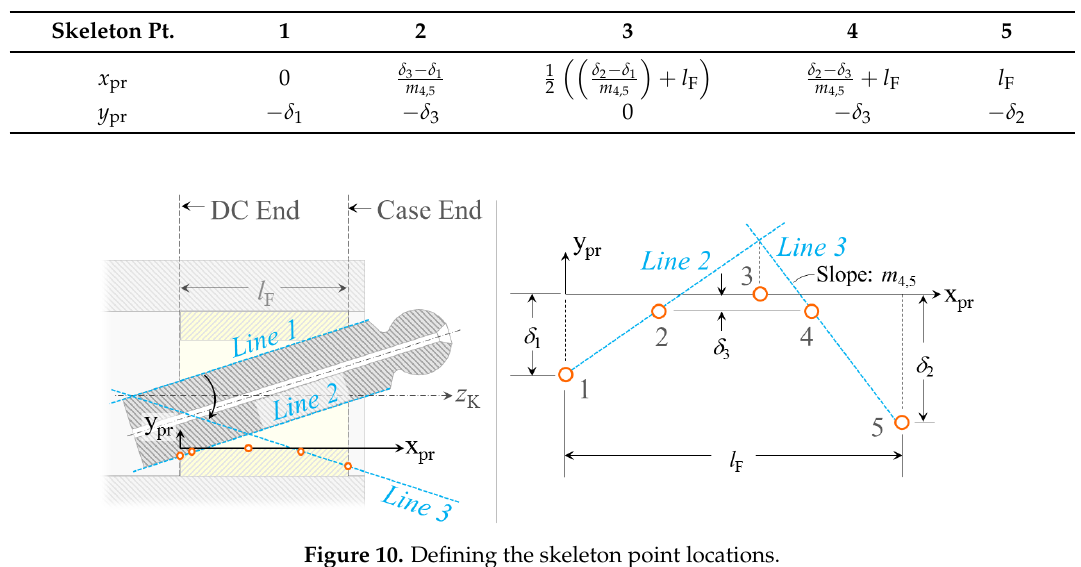
Figure 10. Defining the skeleton point